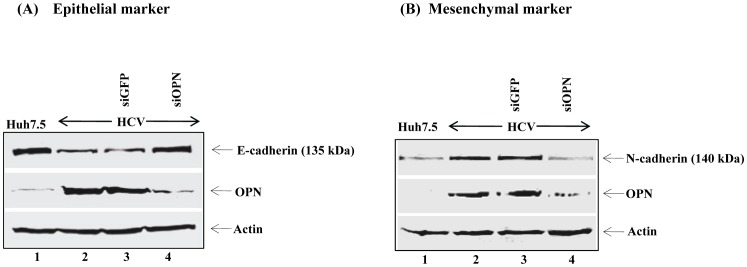

HCV induces EMT via OPN.
HCV-infected cells were transfected with siOPN and siGFP as described in
                            Materials and Methods. At 72 h posttransfection, cells were harvested
                            and equal amounts of cellular lysates were immunoblotted with
                            anti-E-cadherin (A), anti-N-cadherin (B), and anti-OPN (A, B). Actin was
                            used as protein loading control.